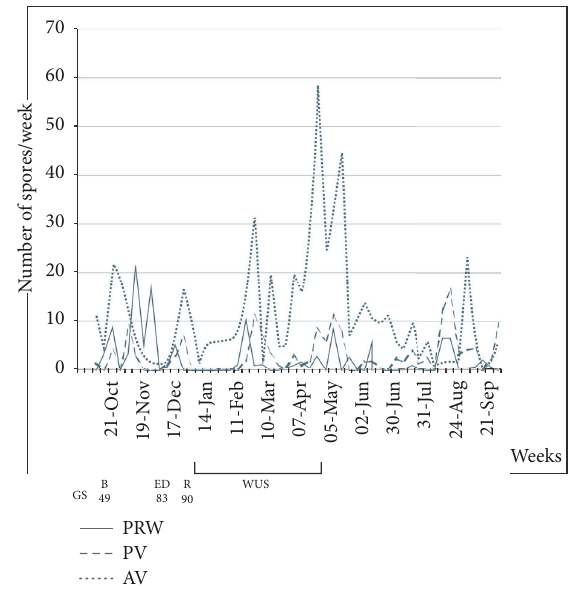
Figure 6: Number of PRW, PV, and AV of Zymoseptoria tritici during the second period. The wheat crop was harvested on December 18, 1999. References: type of spores: PRW: pycnidiospores in rain water; PV: pycnidiospores in Vaseline; AV: ascospores in Vaseline. Growth stages of wheat following Zadoks et al. 1974: S (sowing); CE (coleoptile emergency); i (inoculation); B (boot); ED (early dough grain); R (ripening); WUS (wheat unburied stubble); dates corresponding to each activity and growth stage in the